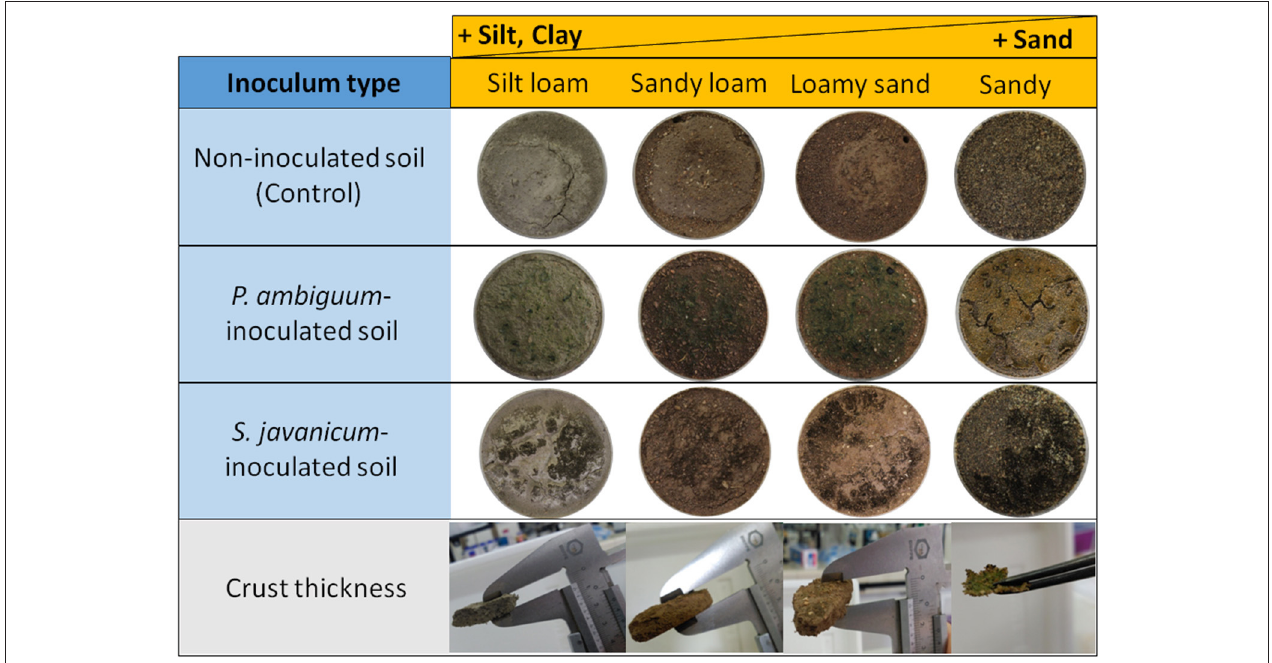
FIGURE 1 | Picture of the control and inoculated samples for the different textured soils, and thickness of the crust developed on each soil type.